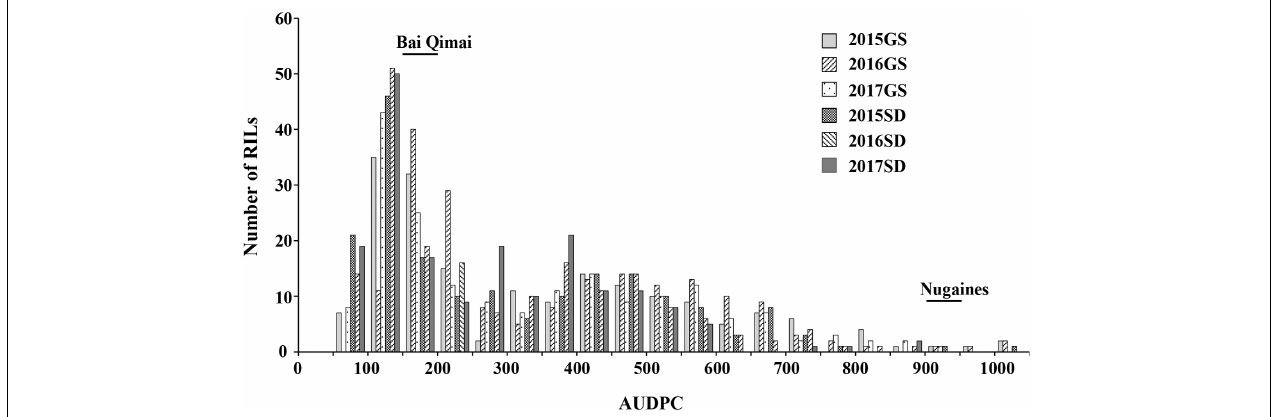
FIGURE 2 | Frequency distribution of leaf rust severities (measured in AUDPC) for the 186 recombinant inbred lines from NG × BQM in field trials under natural infections of Puccinia triticina during 2015–2017 in Gansu (2015GS, 2016GS, and 2017GS) and Shandong (2015SD, 2016SD, and 2017SD).